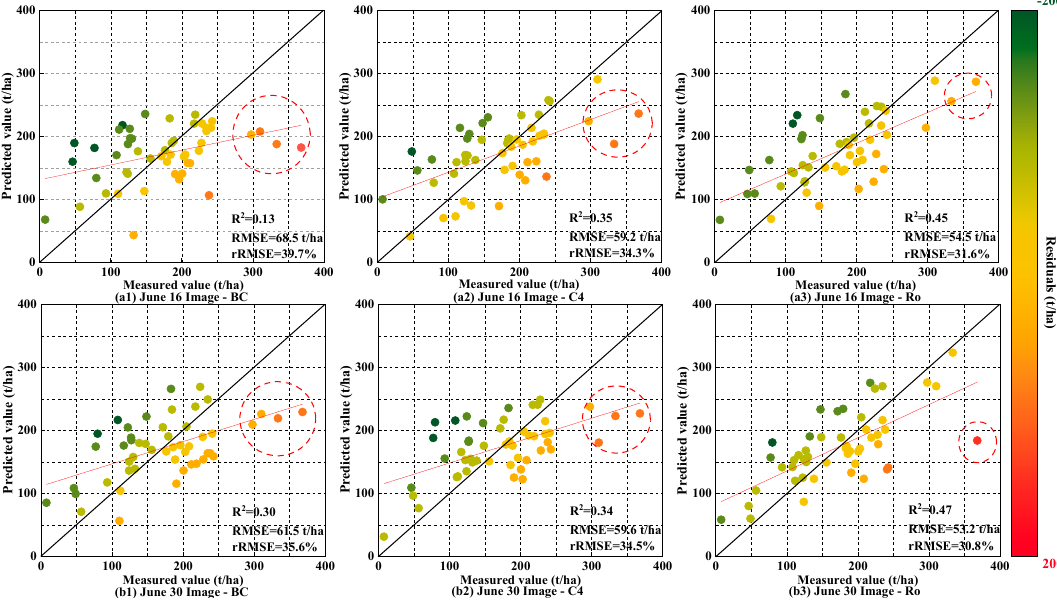
Figure 10. Scatterplots between predicted and ground-measured AGB using three categories of optimal feature sets obtained by SIS.